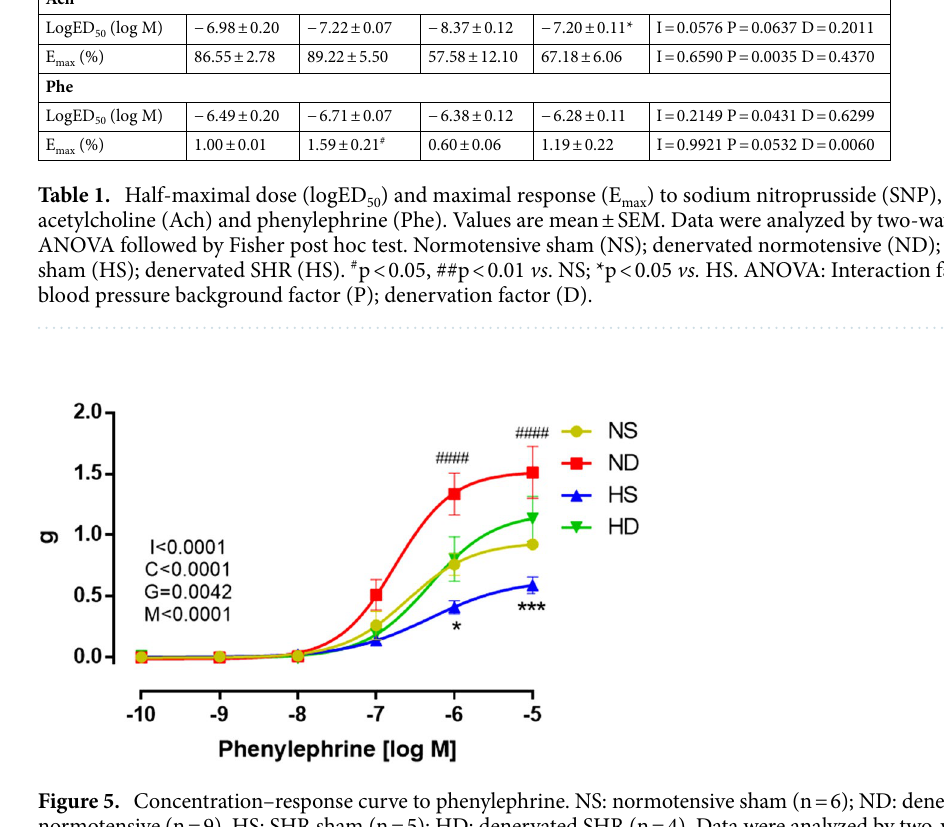
values (green upside-down triangles vs. yellow circles). More importantly is the fact that hypertensive sham rats showed a contractile response in the three last doses of the Ach curve, indicating endothelial dysfunction, which did not occur in hypertension animals undergoing renal denervation. Endothelium-dependent and endothelium- independent relaxation in absolute values are presented as supplementary data (see supplementary Fig. S2). RDN effects on aortic contractile response. Figure 5 represents aortic contractile response when ves- sel rings were exposed to a concentration–response curve to phenylephrine (α1-agonist). Yellow circles rep- resent Wistar sham group (control). When denervated (red squares), Wistar rats showed a greater contractile response when compared to control, also represented by a greater maximal response (E max , Table 1). The same behavior was observed in hypertensive animals; when denervated, SHR showed increased contractile response when compared to their control (blue triangles vs. green upside-down triangles). In summary, RDN increased the contractile response to phenylephrine for both normotensive and hypertensive rats, leading the latter to control values.